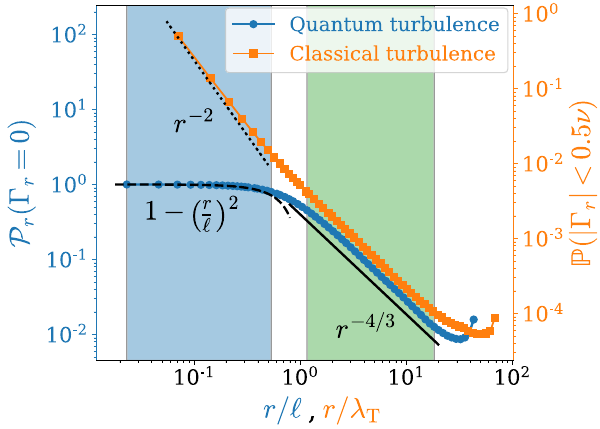
FIG. 6. Probability of having zero circulation in gGP simu- lations (blue line) and of having a weak circulation in Navier- Stokes simulations (orange line). The dashed lines show their respective predictions at large and small